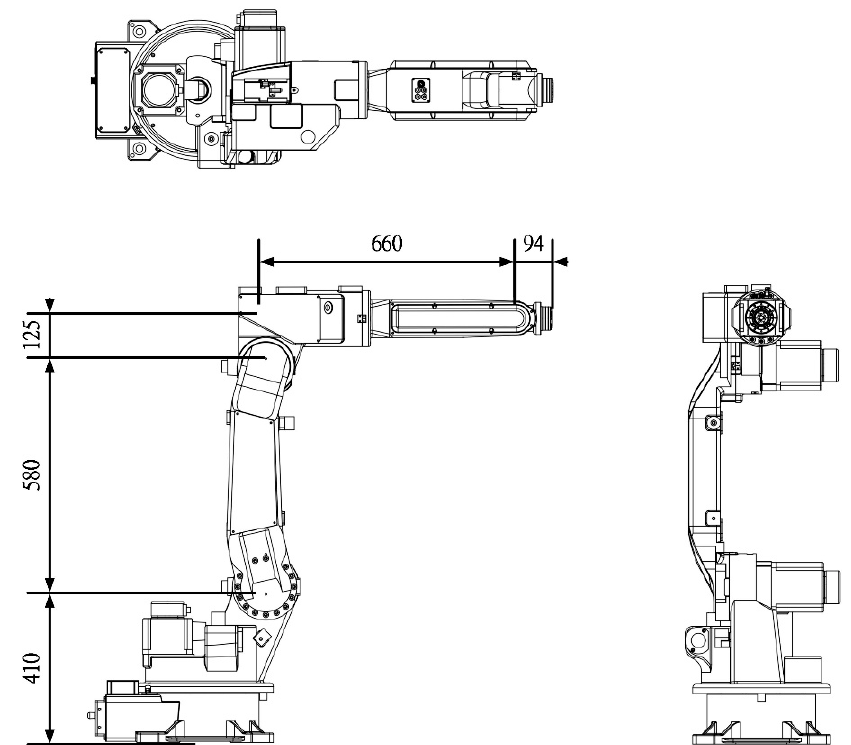
Figure 8. Industrial Technology Research Institute 12A62 robotic arm dimensions.